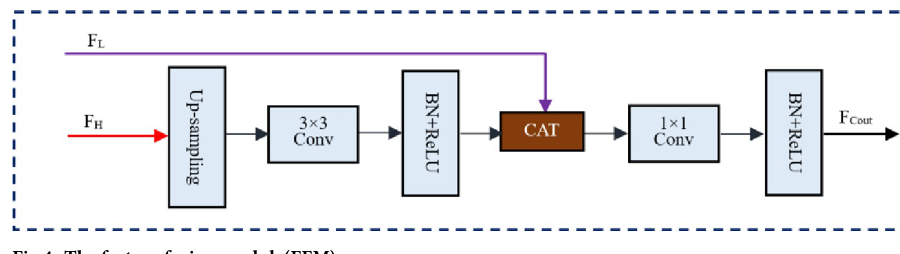
Fig 4. The feature fusion module(FFM).